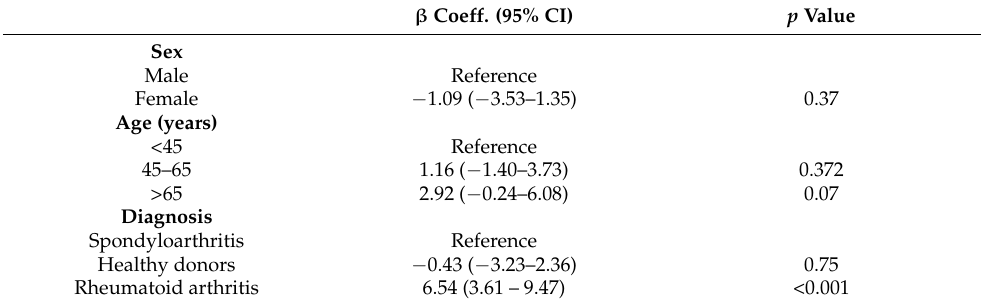
Table 2. Relationship between Gal1 (ng/mL) serum levels and diagnosis.